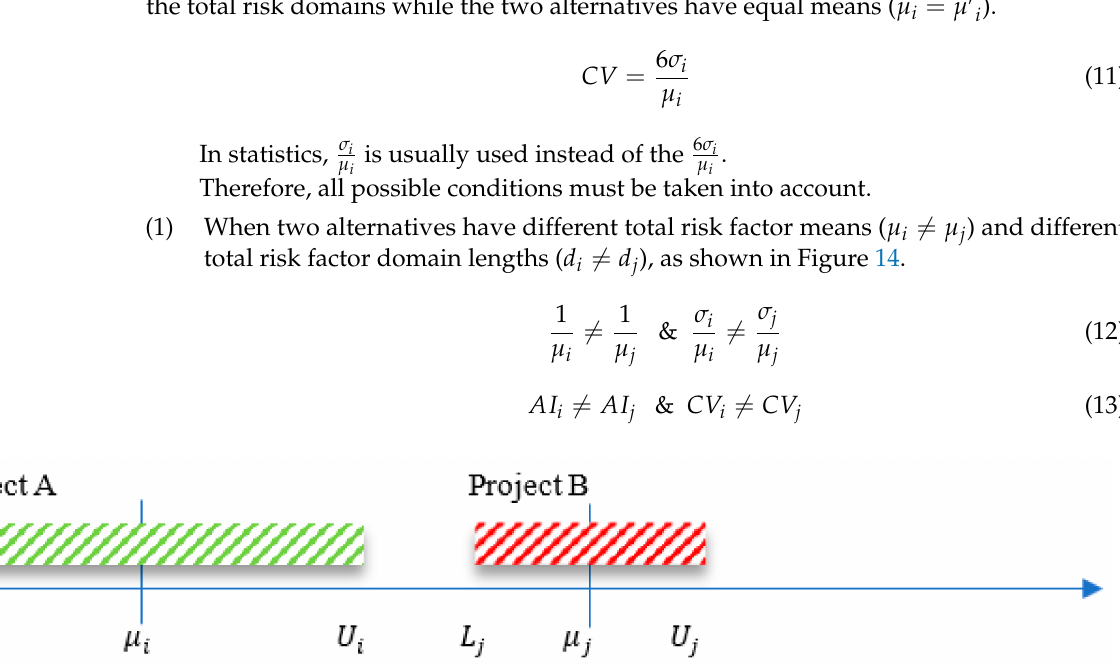
Figure 14. Possible condition one: different means and different domain lengths.